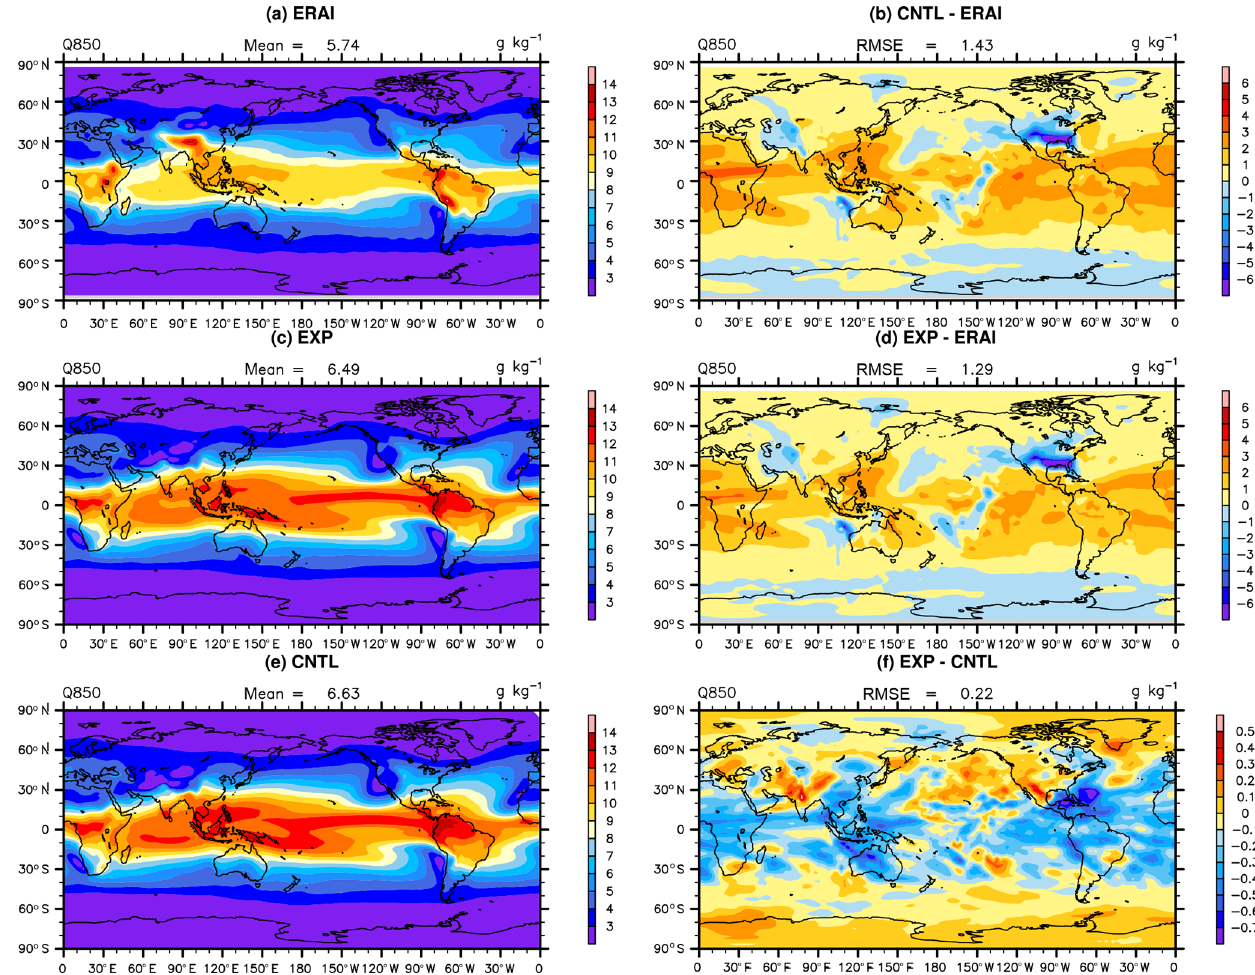
Figure 6. The spatial distribution of specific humidity at 850hPa of (a) observation, (b) CNTL–observation, (c) EXP, (d) EXP–observation, (e) CNTL, and (f)